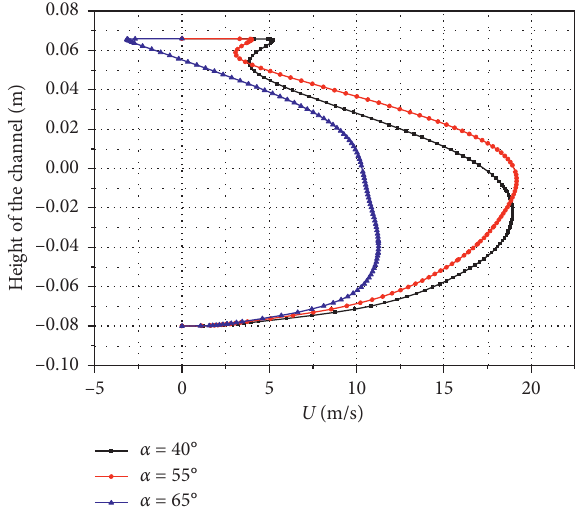
Figure 9: Axial velocity profiles upstream of the second baffle at x � 0.345m for different values of inclination angles: φ 1 � 40 ° ; φ 2 � 55 ° ; φ 3 � 65 °